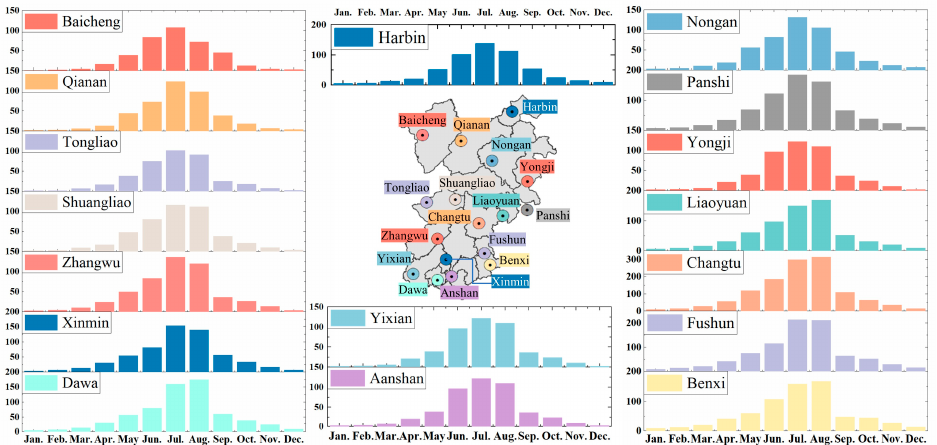
Figure 4. Spatiotemporal distribution of total monthly precipitation at each meteorological station in Songliao Plain.